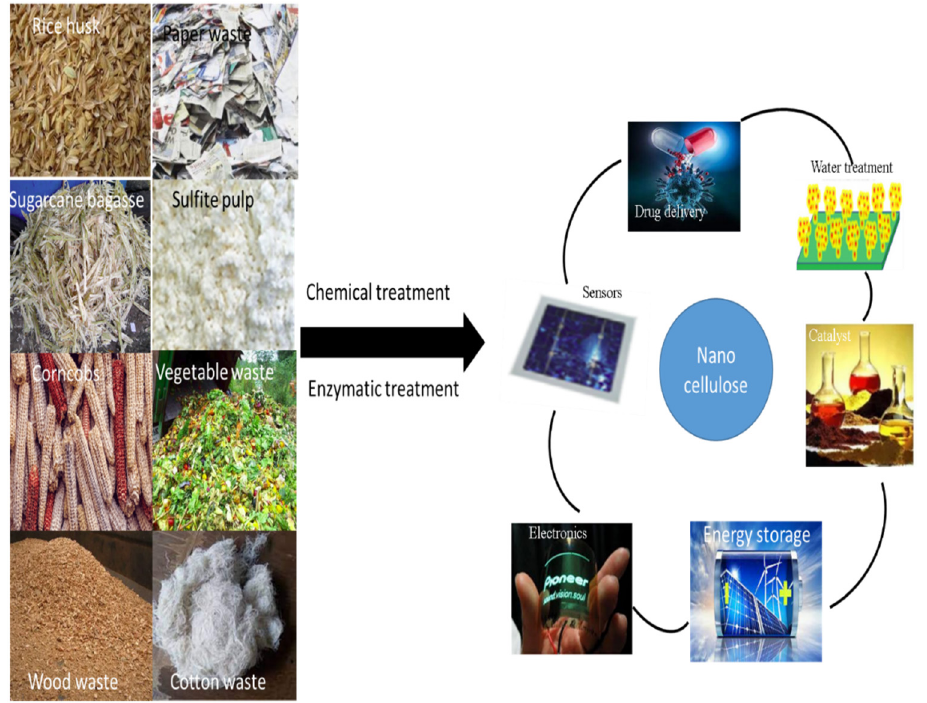
Figure 6. Potential applications of nanocellulose from waste biomass to value-added products (adapted and modified from Thakur et al. [69]).